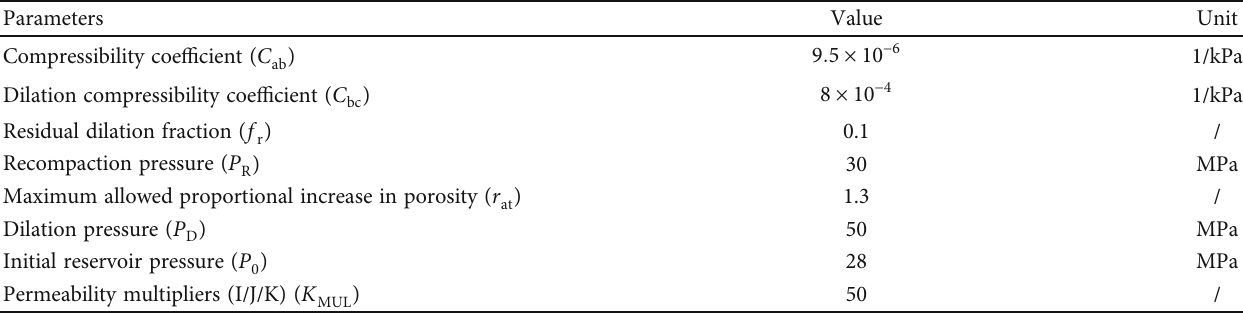
Table 2: Parameters used in the dilation-recompaction